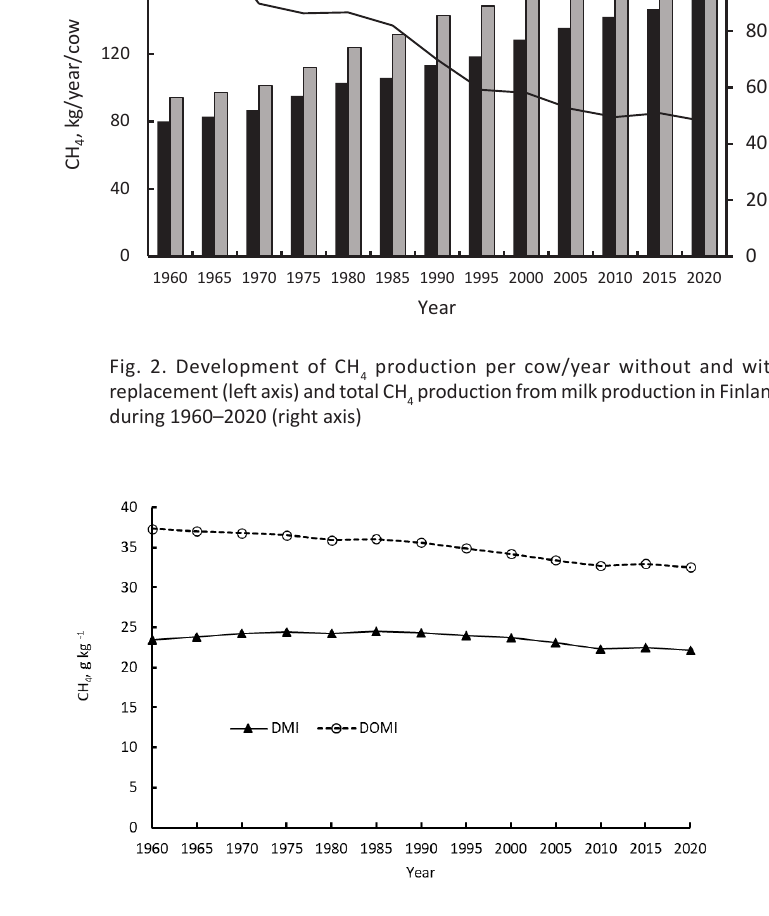
Fig. 3. Development in CH yield of Finnish dairy cows from 1960 to 2020 4 per kg dry matter intake (DMI) and digestible organic matter intake